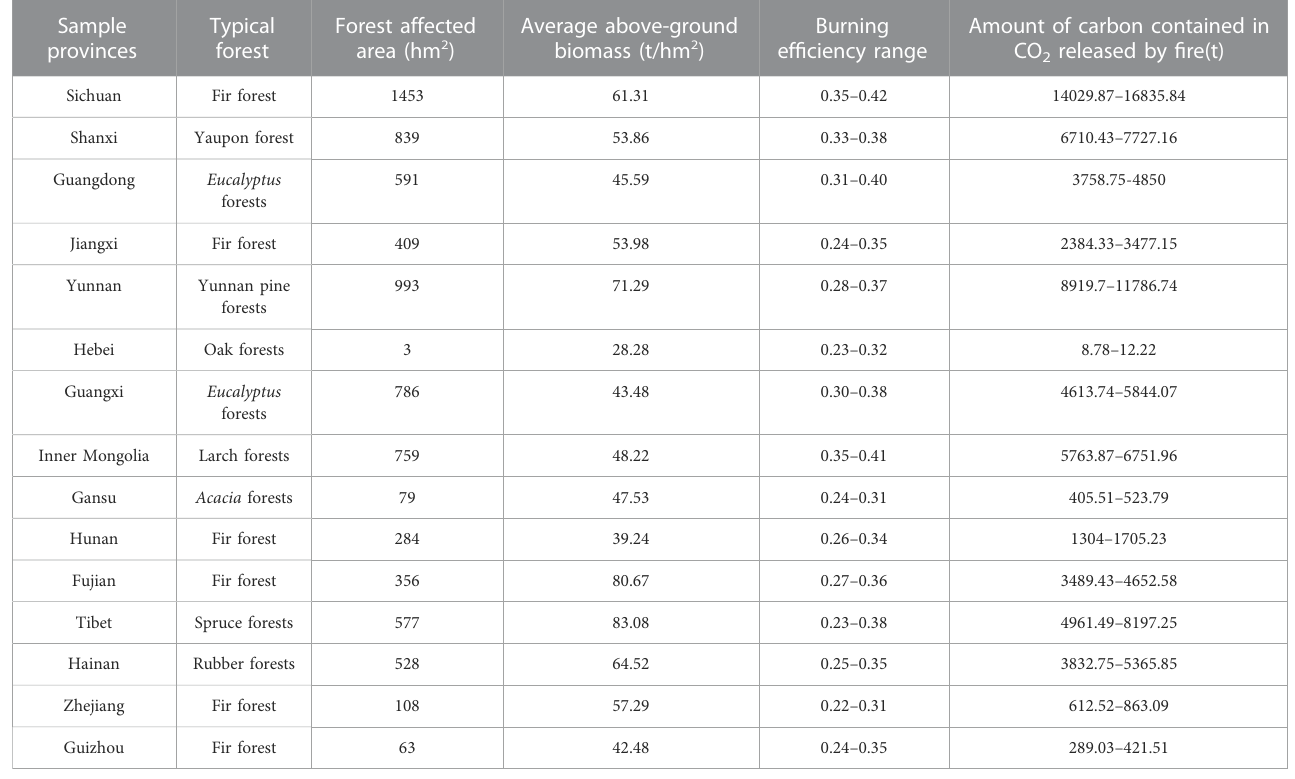
TABLE 4 Estimation of carbon emissions from forest fi res in sample provinces in 2020. Sample Typical provinces